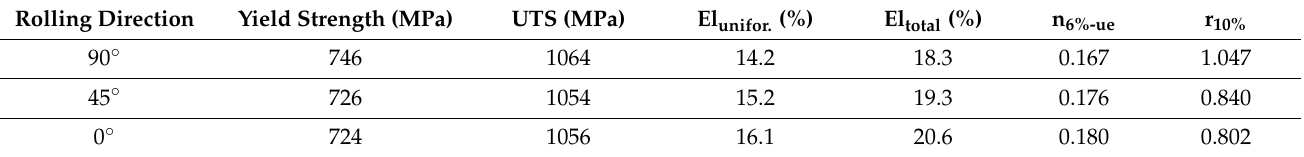
Table 2. Mechanical properties measured in the tensile test.